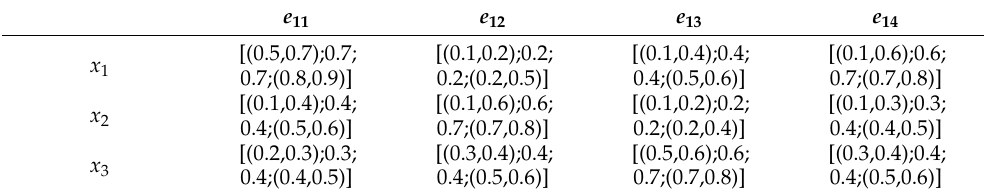
Table A10. The different risk evaluation values subordinated by influencing factors of B 1 at time t 3 .